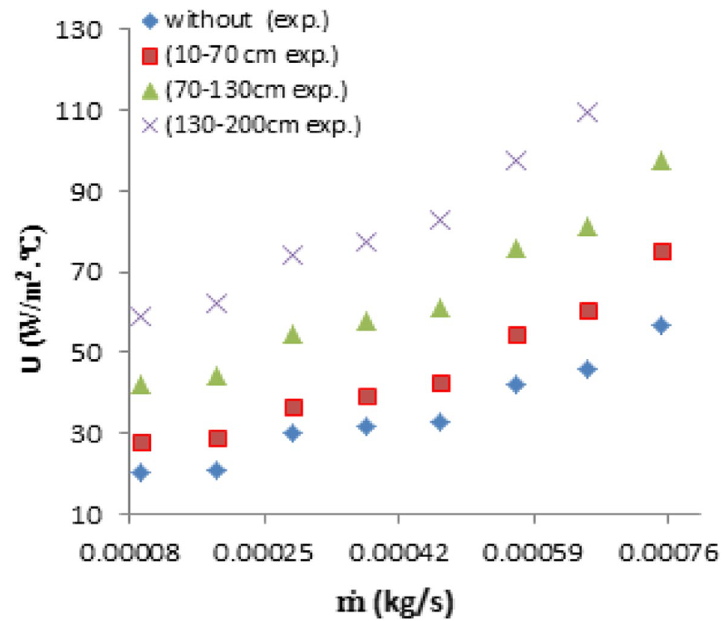
Fig. 9 Over heat transfer coefficient versus air mass flow rate with and without bumpers